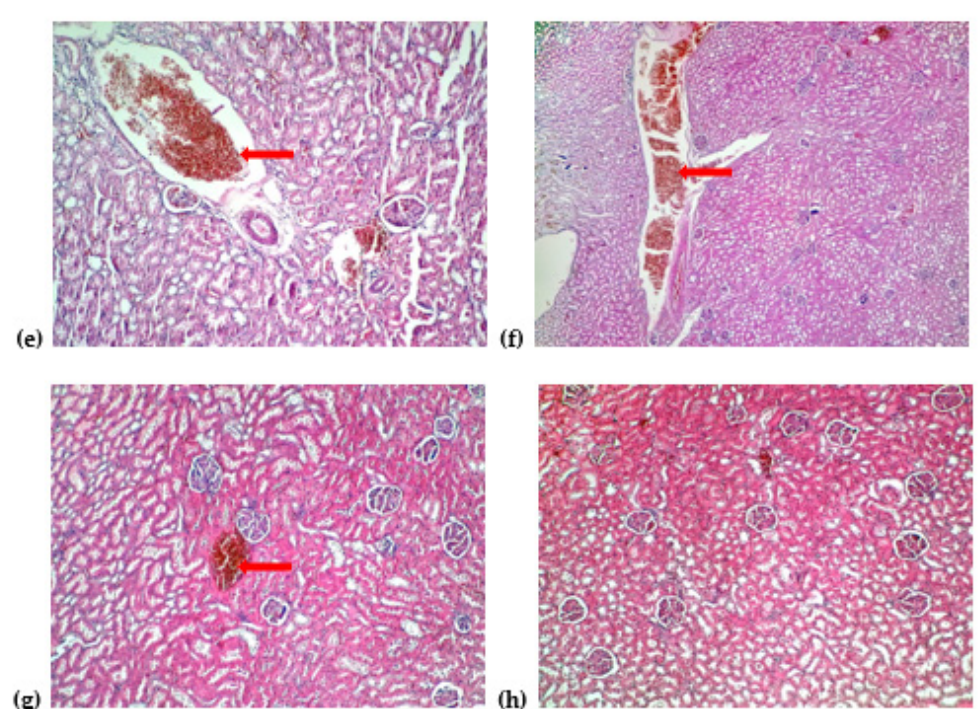
Figure 8. Histopathological examinations of the kidney tissue. ( a ) C (normal architecture of the kidneys), ( b ) AMI (blood stasis with well recognizable integral erythrocytes in a congested blood vessel (red arrow)), ( c ) T1DM (glomerular collapse (yellow arrow) and blood stasis with well recognizable integral erythrocytes in a congested blood vessel (red arrow)), ( d ) T1DM-AMI (glomerular collapse (yellow arrow) and blood stasis with well recognizable integral erythrocytes in a congested blood vessel (red arrow)), ( e ) S-T1DM-CC-AMI (blood stasis (red arrow)), (f) CC-T1DM-CC-AMI (blood stasis (red arrow)), ( g ) S-T1DM-NC-AMI (blood stasis (red arrow)), ( h ) NC-T1DM-NC-AMI (normal architecture of the kidneys).